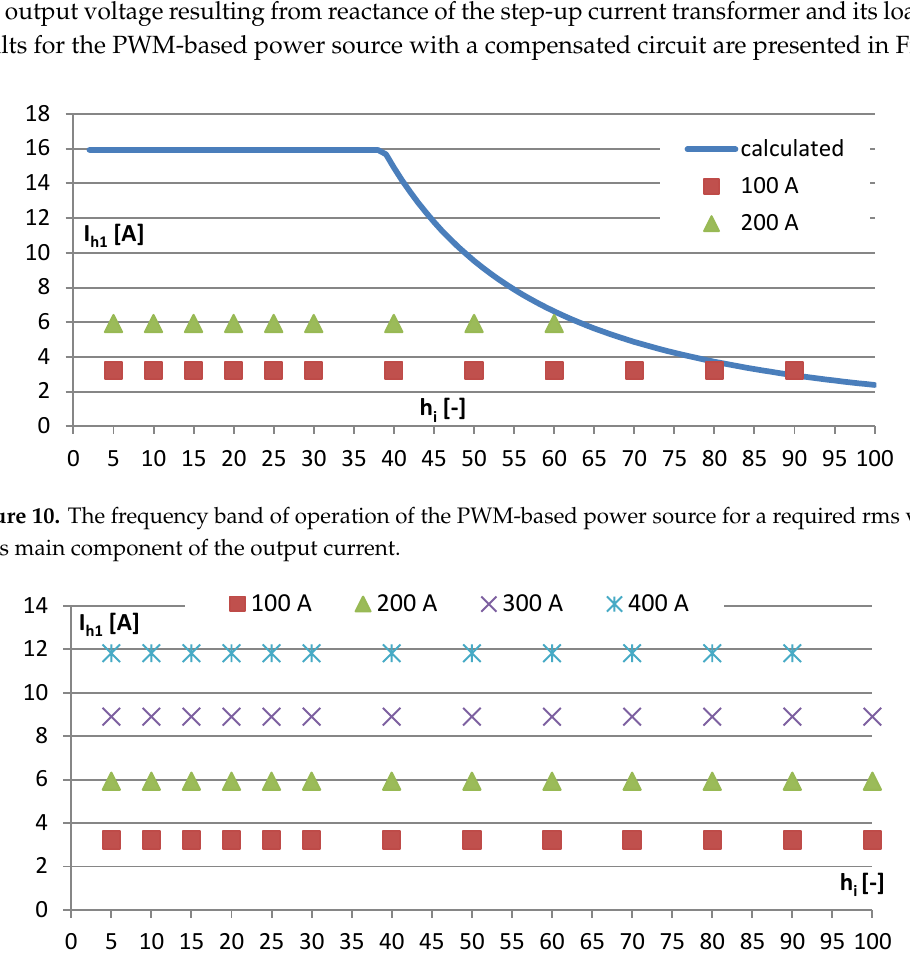
Figure 11. The frequency band of operation of the PWM-based power source for a required rms value of its main component of the output current with compensation.